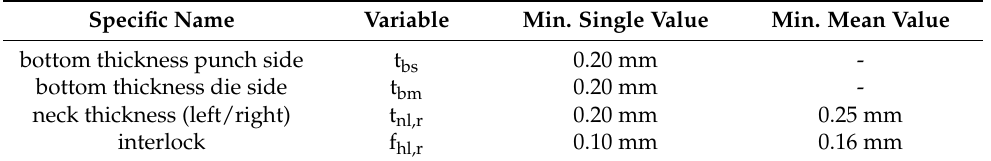
Table 1. Limit values for a clinch joint in according to DVS-guideline [10].